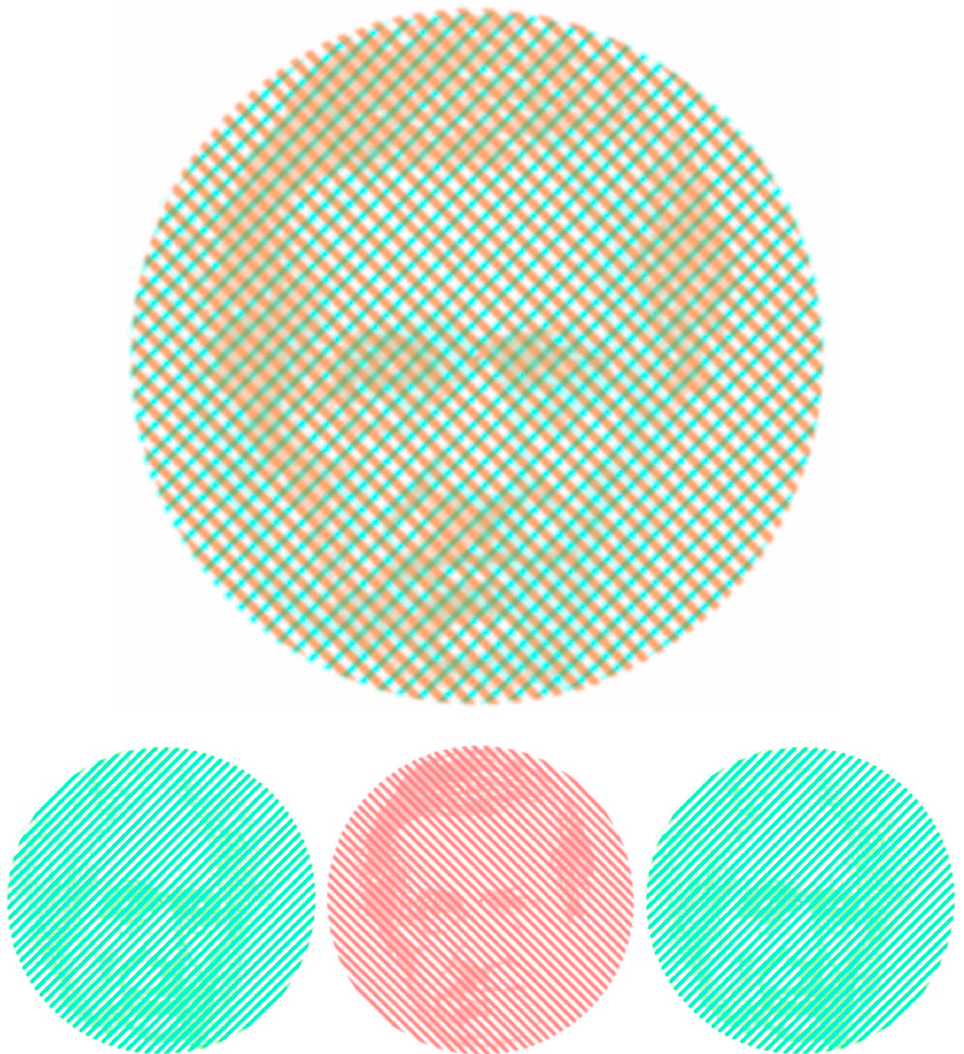
Figure 4. Rivalling researchers by Nicholas Wade. Portraits of Wheatstone and Brewster are embedded in orthogonal gratings.